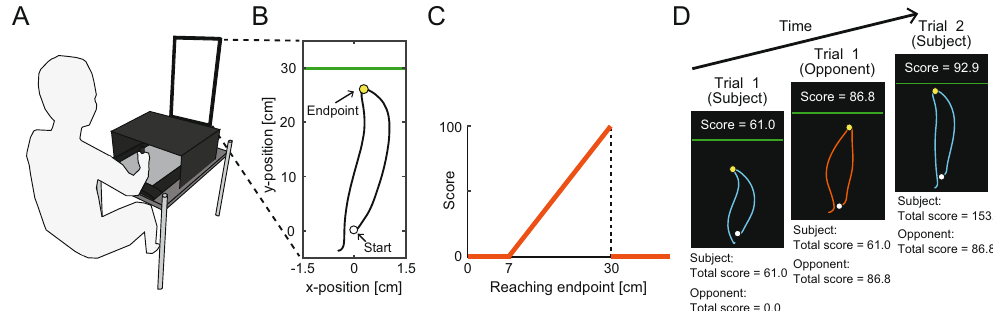
Figure 1. Experimental set up (“game of chicken”). ( A ) Experimental apparatus. The subjects held a digitized pen on a pen-tablet. The stimuli were shown on a vertical screen in front of the subjects. ( B ) Trajectory of reaching movement. The subjects made a quick out-and-back reaching movement, by moving forward from the start initial position (white circle) and returning to it. The reaching endpoint (yellow circle) was calculated as the maximum y-position. ( C ) Asymmetric gain function. The reaching endpoint determined the one-trial score. The maximum score (100 points) was associated with reaching the green boundary line (30 cm). ( D ) Trial-sequence of the competitive task. The subjects and opponents performed the reaching movement in an alternating order. The current total scores for the subjects and opponents were constantly displayed on the screen, indicating the difference in scores. The reaching trajectories (red and blue) were shown only for